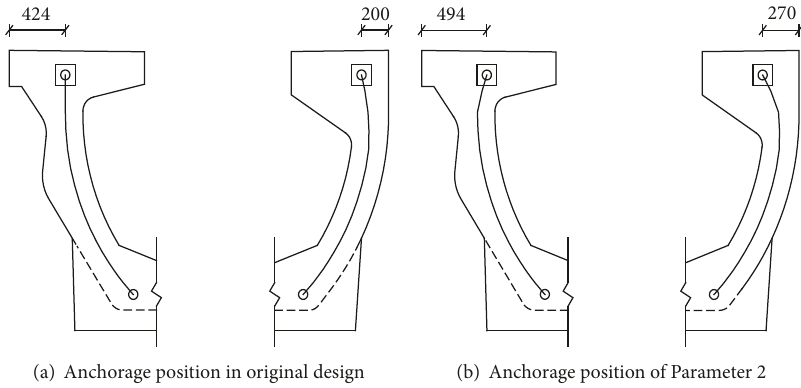
Figure 16: Anchorage position of web prestressed steel comparison (unit: